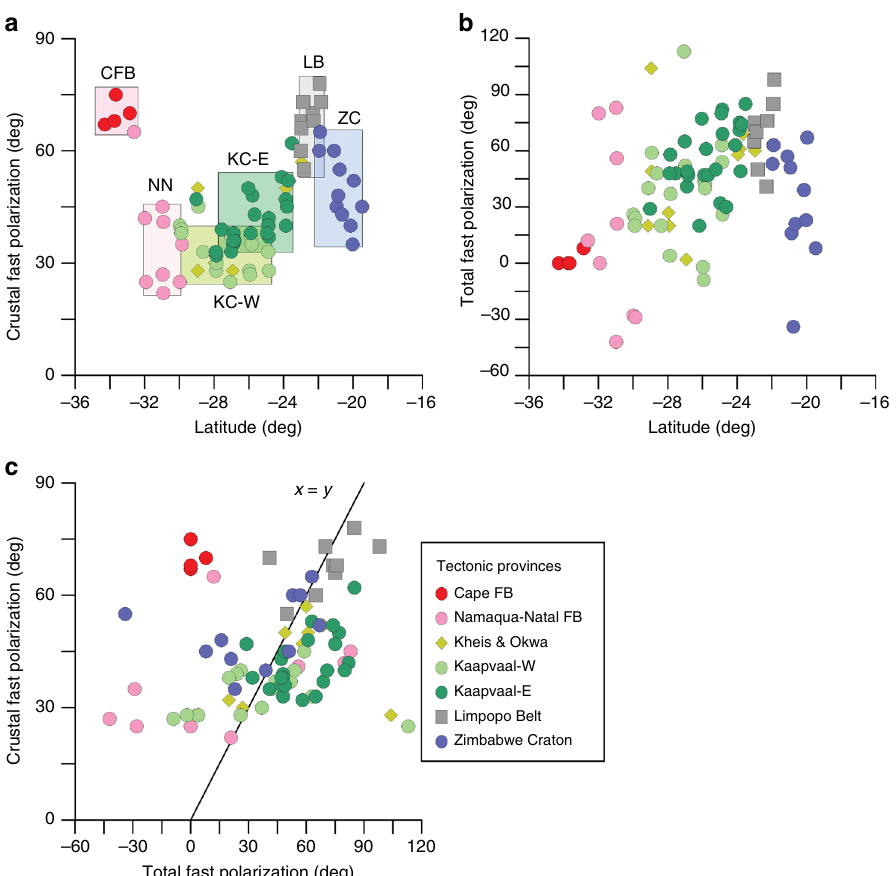
Fig. 6 Observed fast polarisation directions ( φ ) versus latitude for a crustal anisotropy (our results), and b total anisotropy (from SKS splitting 21 ); c cross- plot of φ for crustal anisotropy from RF and for SKS analysis. Colours indicate tectonic province. Abbreviations as in Fig.